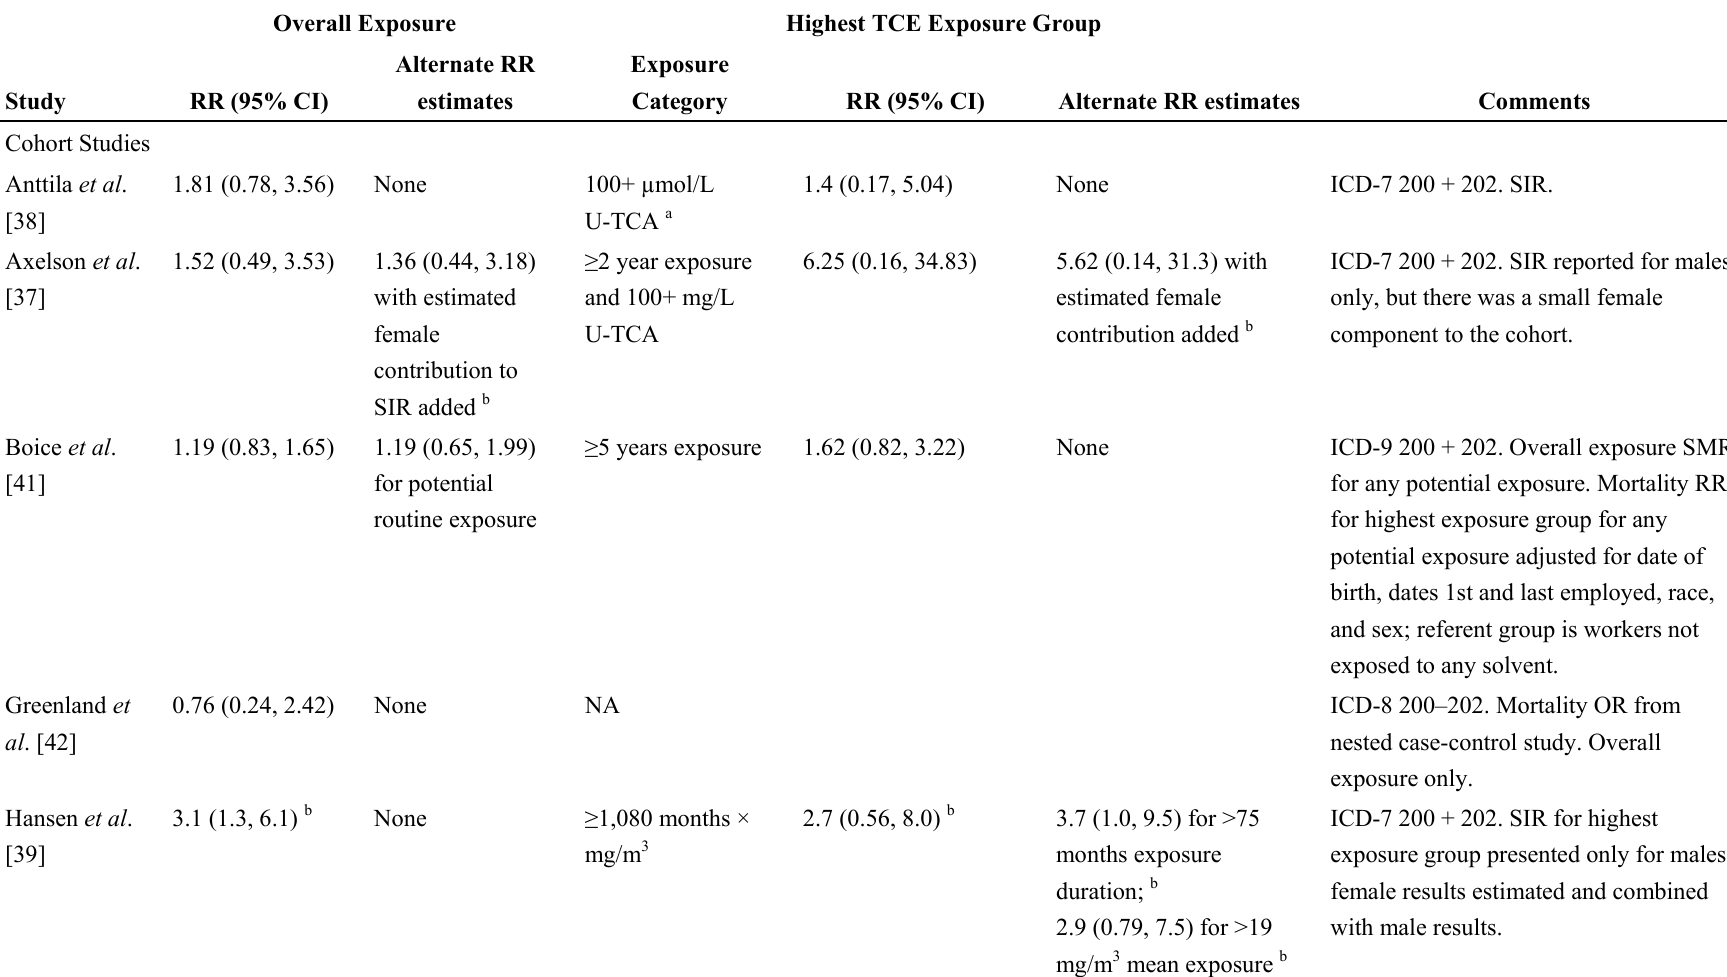
Table 4. Selected RR estimates for NHL associated with TCE exposure (overall and highest exposure group) from cohort and case- control